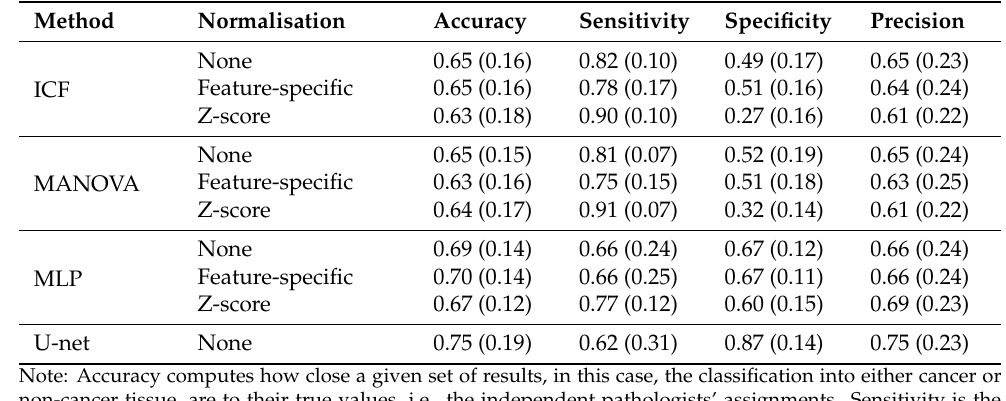
Figure 5. Three examples of tissue sections superimposed with the respective cancer score maps of the different models compared with the assignments (ground truth; red = tumour; blue = non-tumour) by independent pathologists. The cancer score indicates the probability that the cells belong to the tumour tissue, with red representing the highest probability and blue the lowest. ICF = individual cell features, MANOVA = multivariate analysis of variance, and MLP = multilayer perceptron. Table 4. Comparison of the performance of the individual cell features (ICFs), the multivariate analy- sis of variance (MANOVA), and the multilayer perceptron (MLP) models with different normalisation methods and the U-net in terms of agreement with the pathologists’